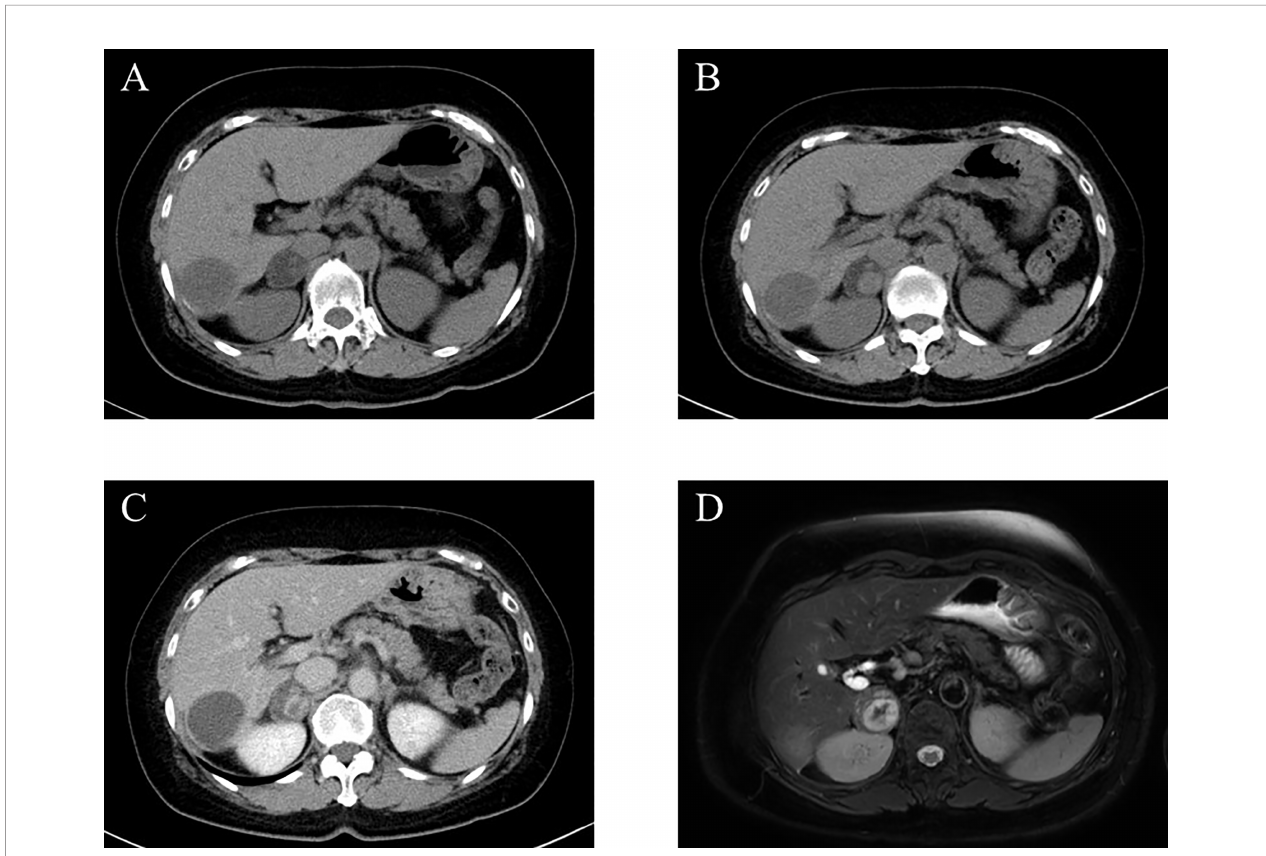
FIGURE 1 | Imaging analysis. (A) Non-enhanced computed tomography (CT) at the fi rst admission. (B, C) Non-enhanced (B) and enhanced (C) CT 3 years after the fi rst admission. (D) T2-weighted magnetic resonance imaging (MRI) at the second